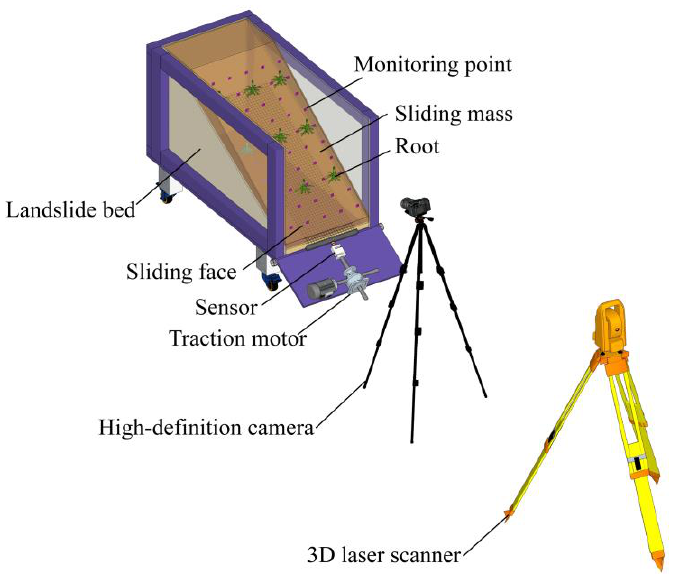
Figure 5. Schematic diagram of the physical model experiment system.